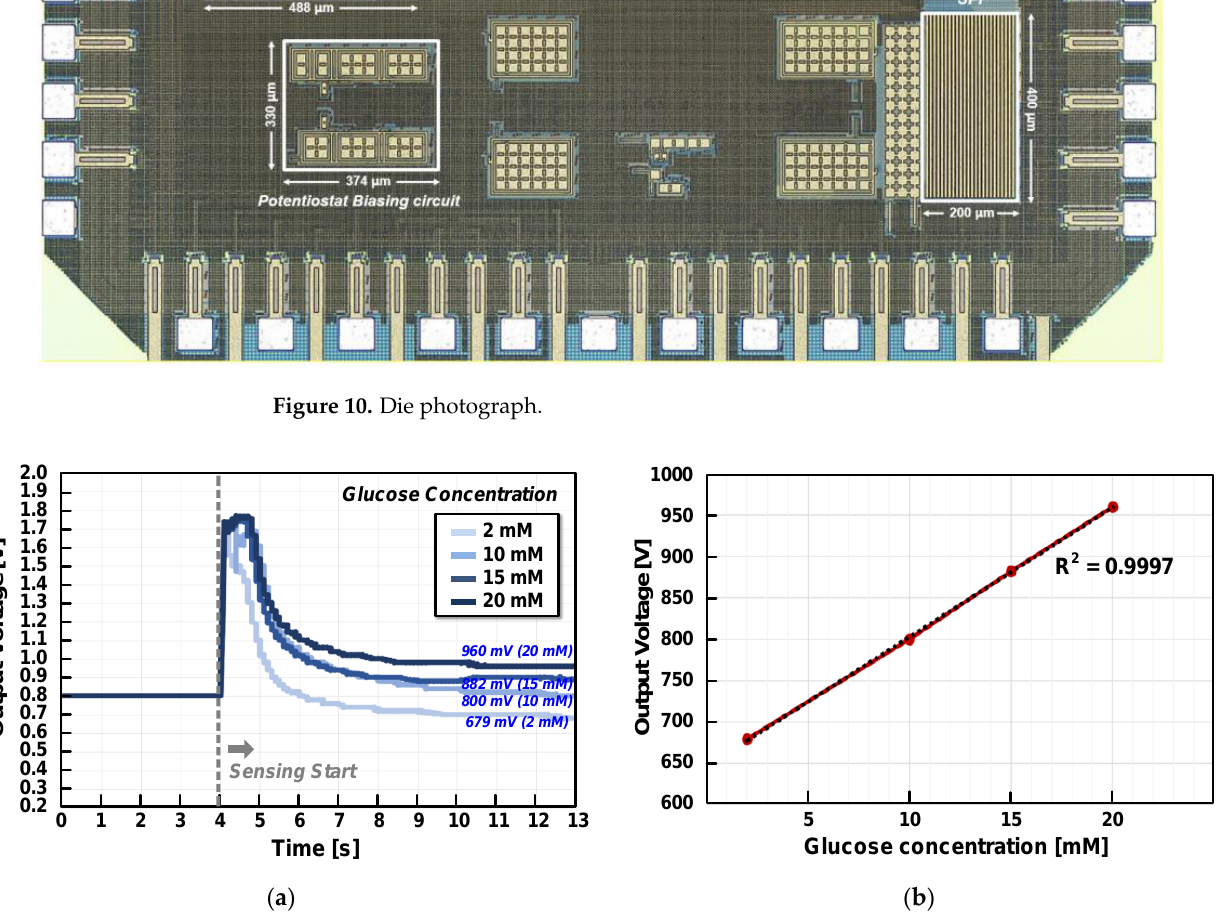
Figure 11. FDDA output voltage with different glucose concentrations: ( a ) transient result; ( b ) line- arity.